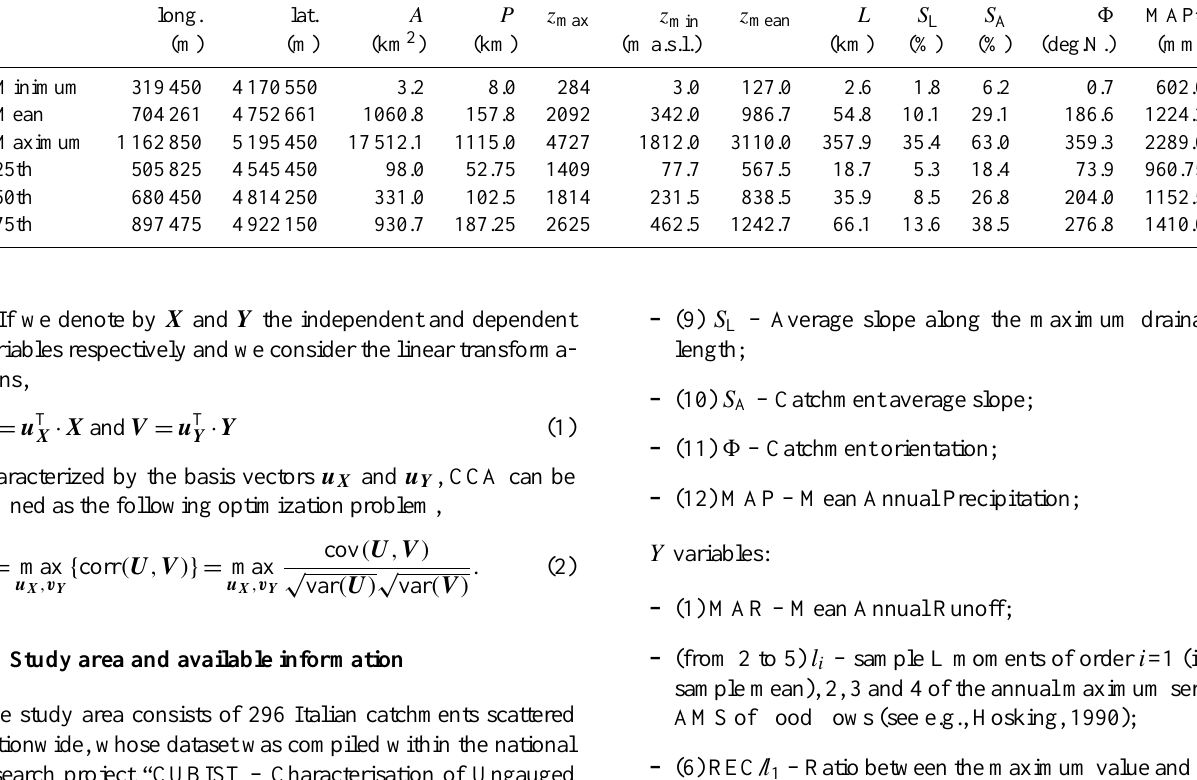
Table 1. Minimum, mean and maximum values, and 25th, 50th and 75th percentiles for the set of X variables considered in the study. These data were either derived from a SAR-DTM (Synthetic Aperture Radar – Digital Terrain Model) with grid size 100m or * retrieved from Rep. no 17 of the former Italian SIMN (National Hydrographic Service of Italy).